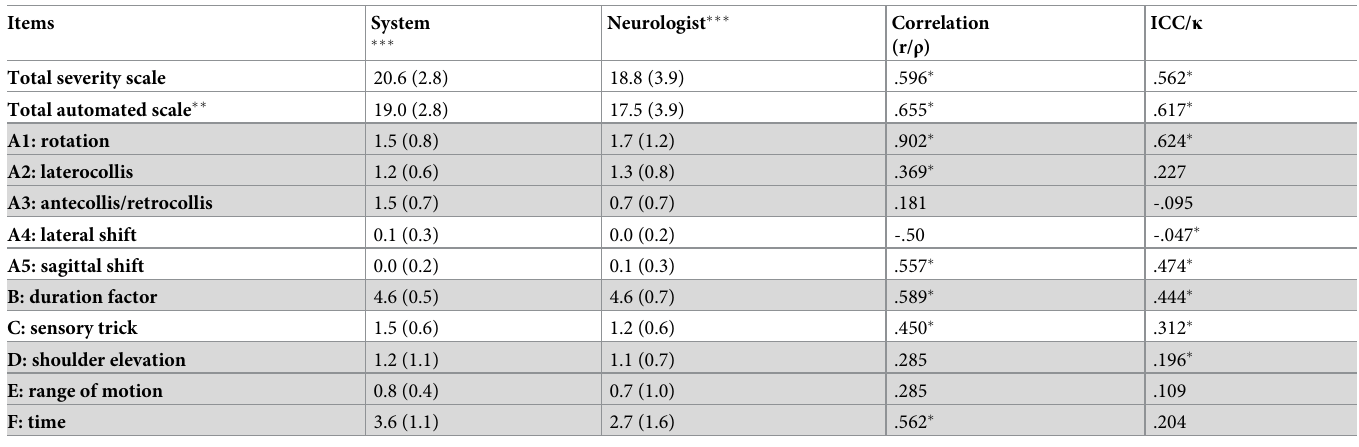
Table 3. Validity and accuracy of the